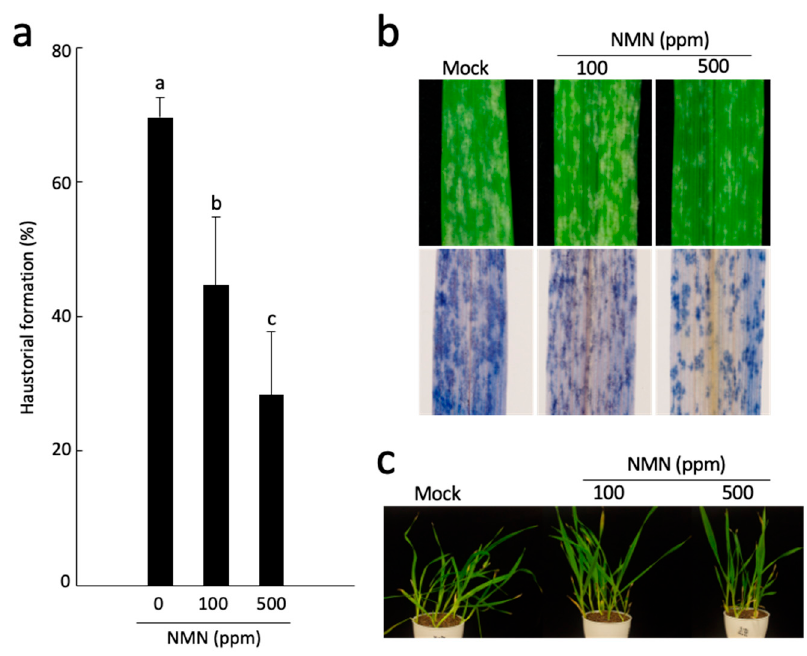
Figure 1. NMN induces penetration resistance to the barley powdery mildew fungus Blumeria graminis f. sp. hordei ( Bgh ). ( a ) The penetration rate of Bgh in NMN-treated epidermal cells of